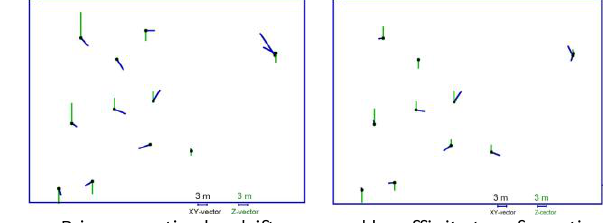
Figure 8. Discrepancies at GCPs by Ziyuan-3 based on intersection with orientation from 2D-orientation